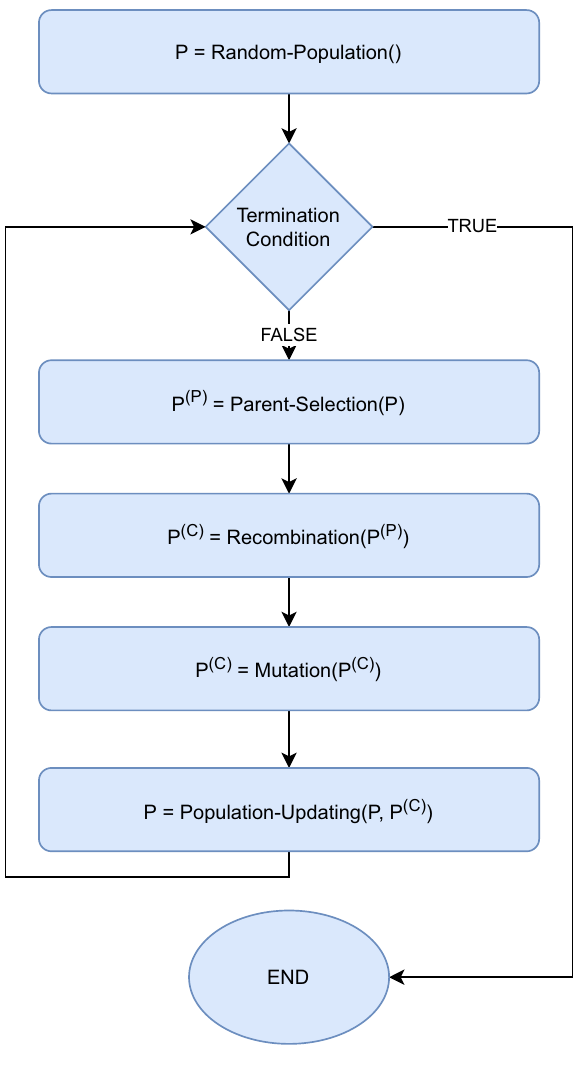
Figure 2. The general scheme of the evolutionary algorithm.